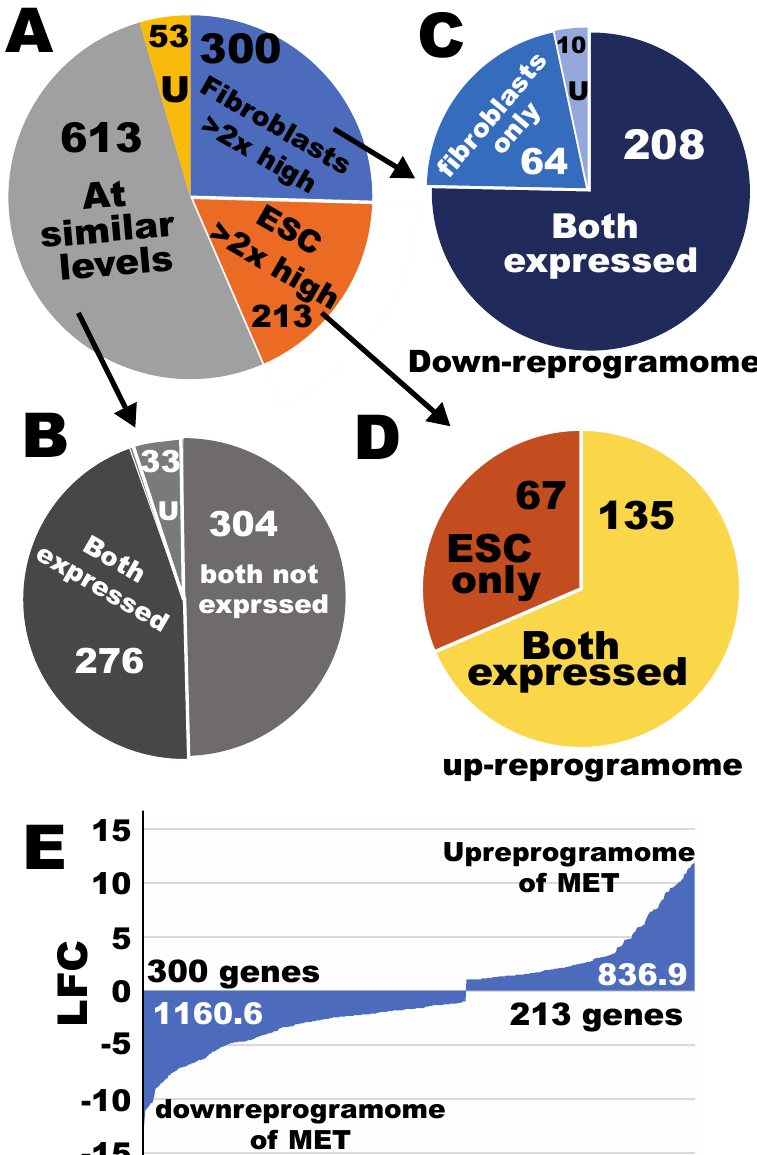
Figure 4. Defining the subreprogramomes for the mesenchymal-to-epithelial (MET) transition during the iPSC reprogramming process from human fibroblasts. ( A ) A pie chart for classification of the MET/EMT genes in the context of human fibroblast-to-iPSC reprogramming. ( B ) sub-classification for the sector of “at similar levels” in ( A ). ( C ) Sub-classification for the sector of fibroblast-enriched genes in pie chart ( A ). ( D ) Sub-classification for the sector of hPSC-enriched genes in pie chart ( A ). ( E ) Quantification of reprogrammikng for the MET subreprogramomes. LFC, log2 (fold changes); U, uncertain genes based on the sorting criteria. See also Supplementary Figures S8–13 and Supplementary Tables S12–14.